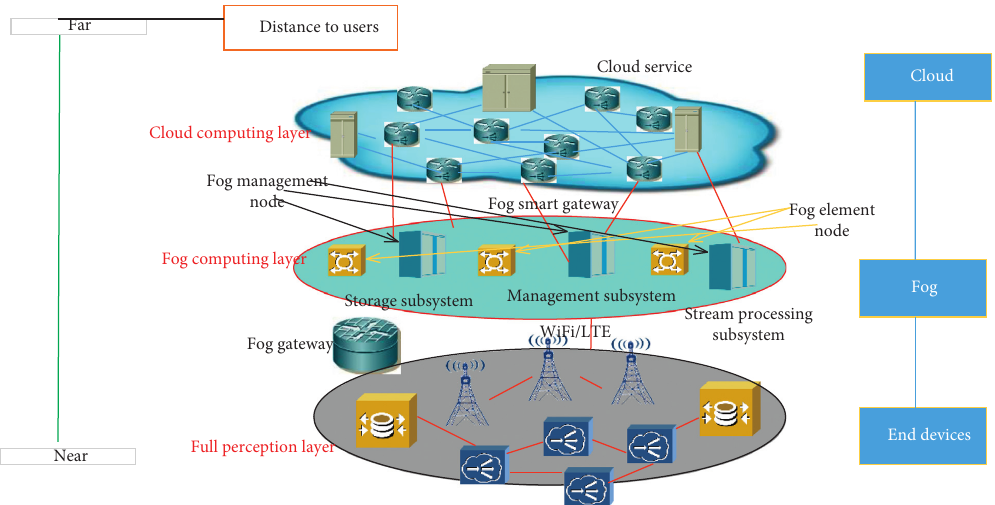
Figure 1: Fog computing architecture